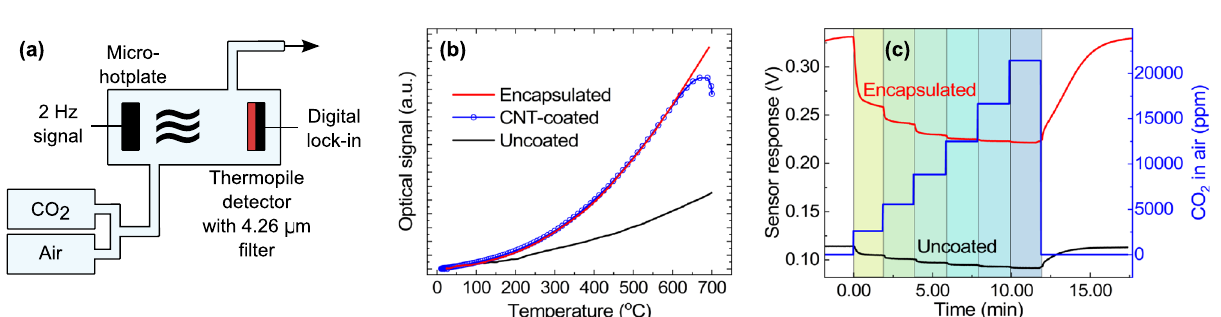
Figure 3. Nondispersive infrared (NDIR) experiment. ( a ) Schematic of the NDIR gas sensor setup. ( b ) Relative optical response, recorded by the thermopile at 4.26 µ m, for an uncoated (black line), CNT-coated (dotted blue line), and encapsulated (red line) micro-hotplate respectively. The detected IR emission from the unencapsulated device (dotted blue line) drops rapidly (minutes) at temperatures above 600 ◦ C, consistent with data presented in Fig. 2b. ( c ) CO 2 sensor response voltage with an uncoated (black line), and encapsulated (red line) micro-hotplate respectively. A ∼ 8-fold increase in relative voltage (cid:31) V = V 0 ppm − V lock − in can be observed for the encapsulated CNT